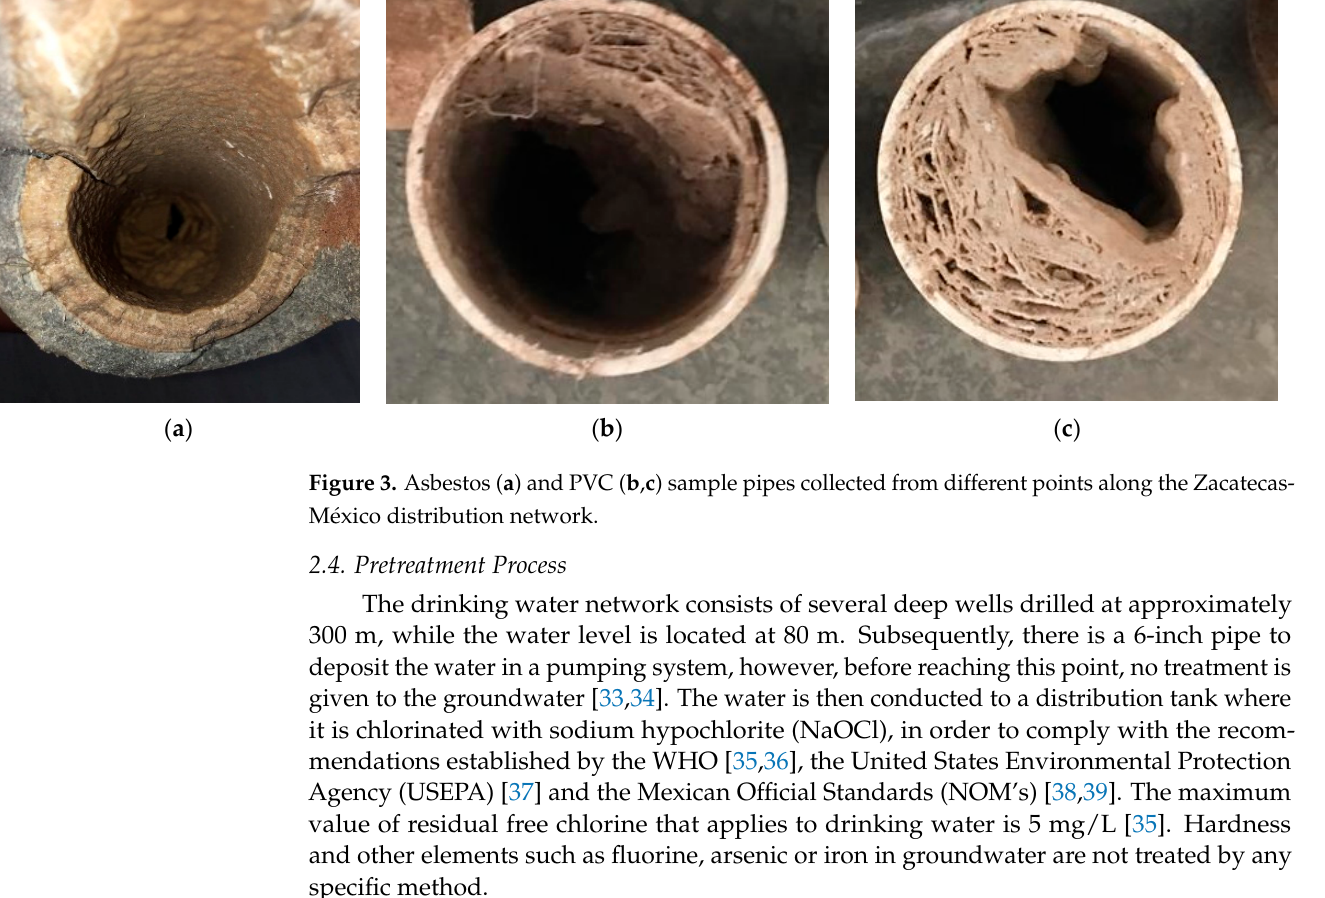
Figure 2. Sampling points in the conurbation area.